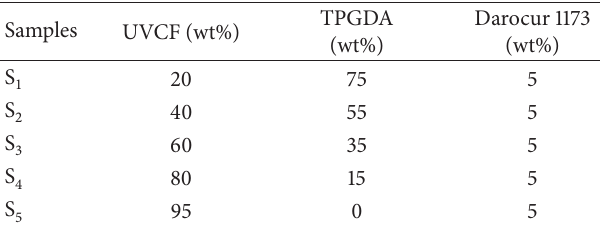
Table 1: Formulations of UV-cured